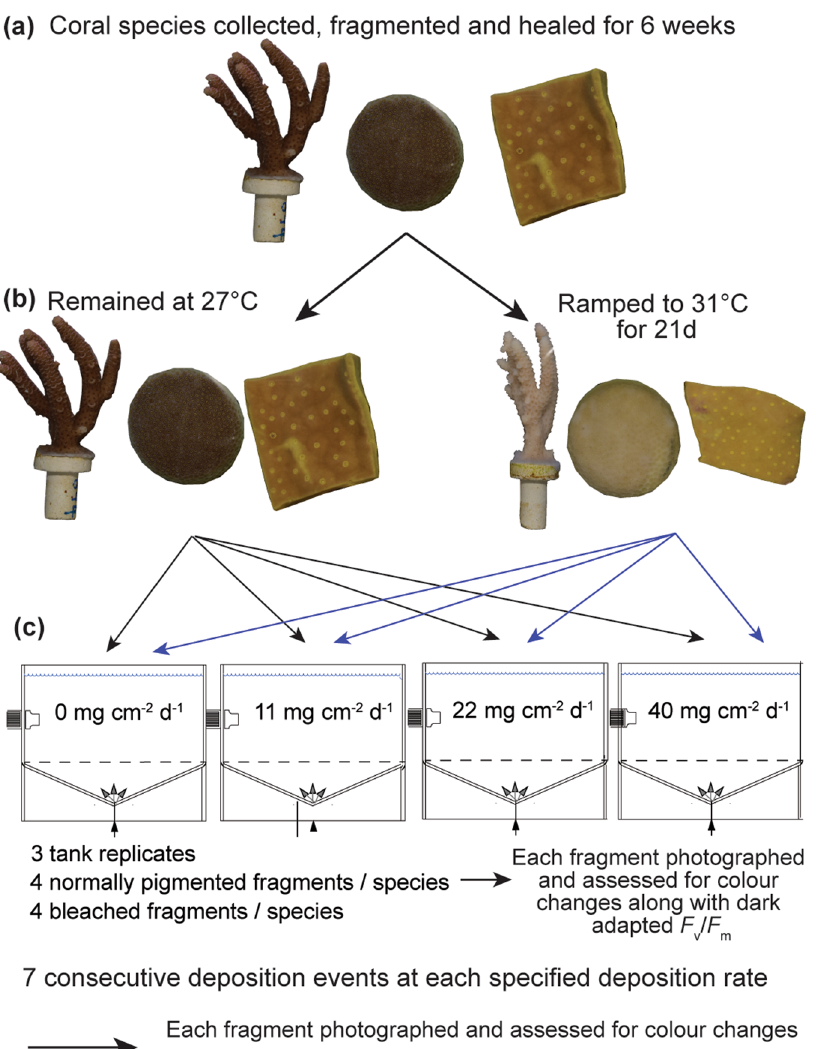
Figure 6. Conceptual diagram of the steps involved in the experiment, including ( a ) the initial healing process, ( b ) bleaching of corals, ( c ) subsequent sediment deposition exposures and health parameters that were assessed at different stages of the